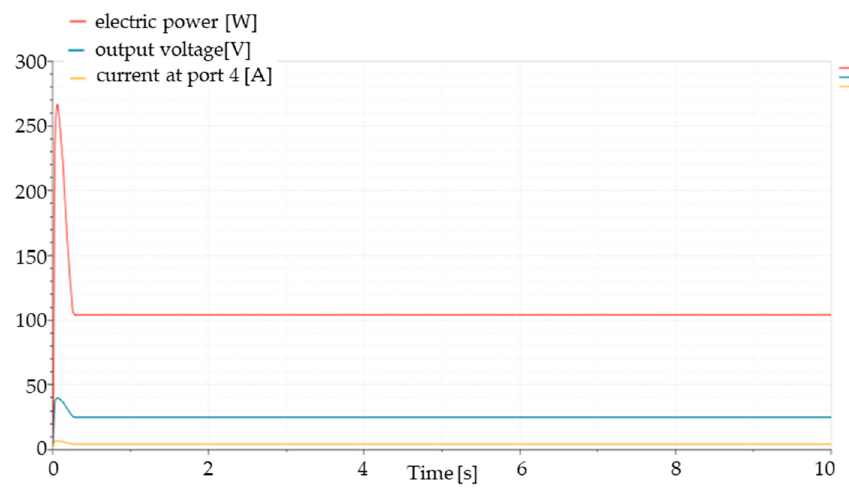
Figure 20. The current intensity, the voltage and the power from the AMESim simulation results in relation to time.